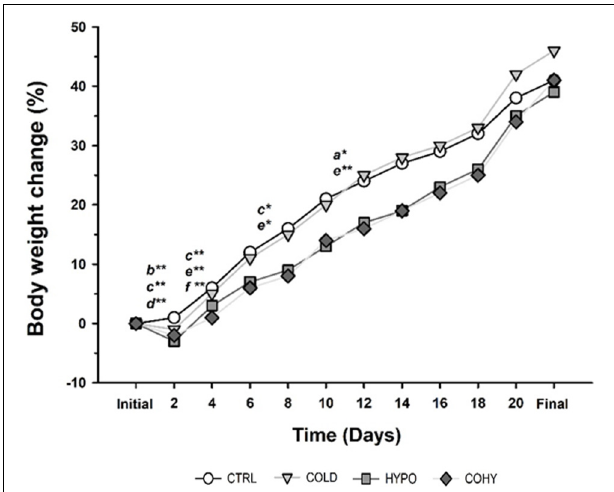
FIGURE 2 | Body weight change during the study. Statistically significant differences are indicated as follows: * p < 0.05, ** p < 0.001 between the following pairs: a, CTRL vs. COLD; b, CTRL vs. HYPO; c, CTRL vs. COHY; d, COLD vs. HYPO; e, COLD vs. COHY; f, HYPO vs. COHY. CTRL, control; COLD, intermittent cold; HYPO, intermittent hypoxia; COHY, intermittent cold + hypoxia.